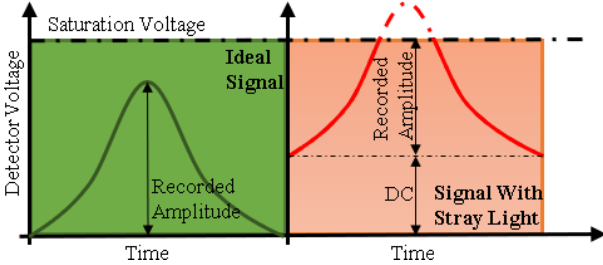
Figure 4. An illustration of the effect of stray light on the signal output of the detector electronics (the transimpedance amplifier). Excess stray light will cause the Gaussian pulse from a particle to stray beyond the saturation point, represented in the red area of the